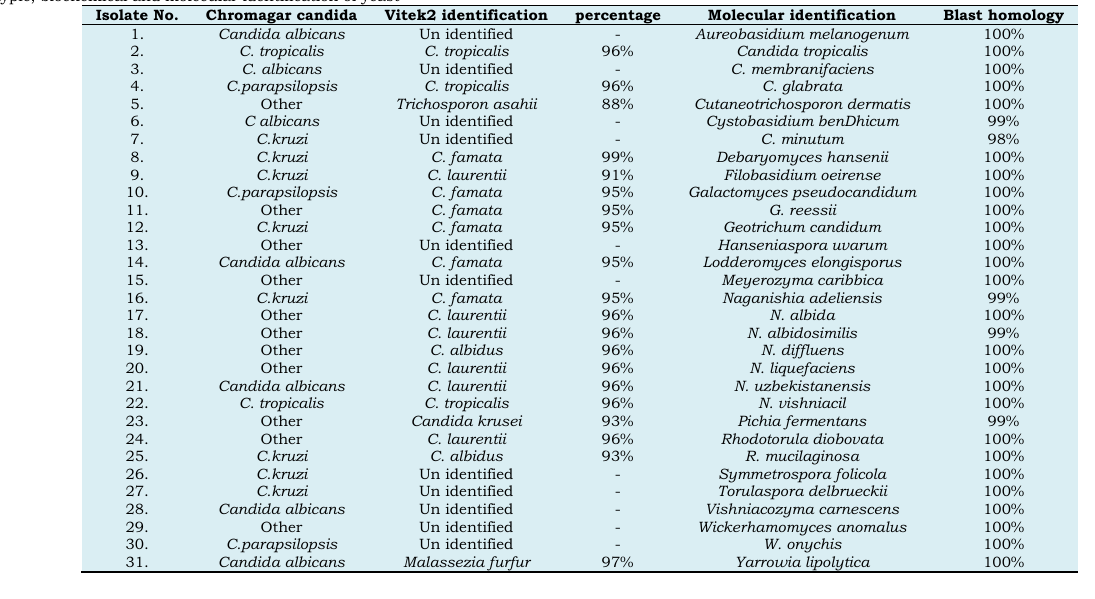
Table 6 Growth of 31 strains on six different culture media